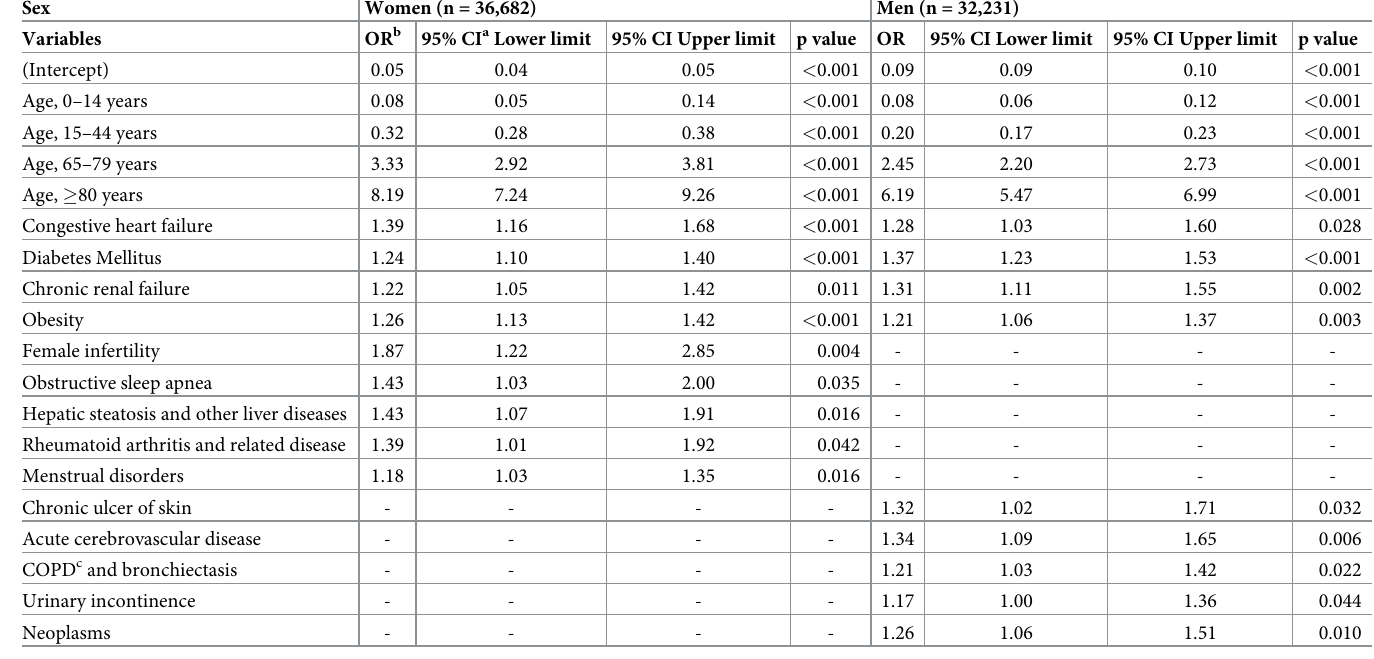
Table 2. Models of likelihood of moderate-to-severe COVID-19 infection according to baseline demographic and clinical variables of the individuals with labora- tory-confirmed infection, by